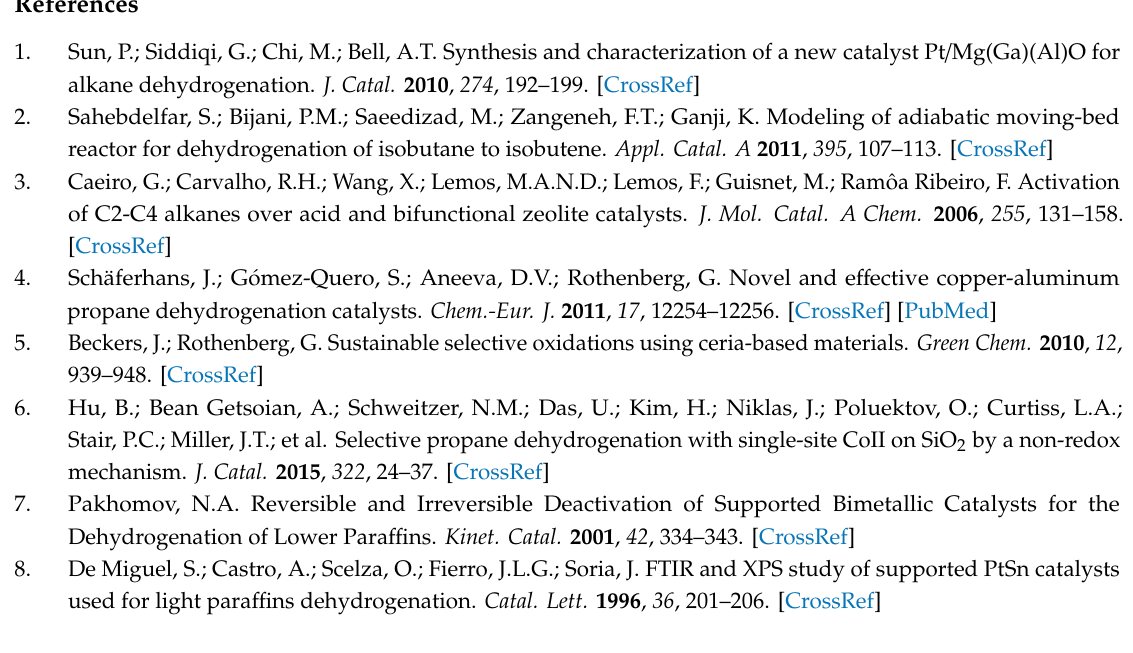
Figure S1: XRD patterns of precursors (A) and the corresponding calcined samples (B): (a) ZnO; (b) MAZ; (c) In / MAZ; (d) PtIn / MAZ. Table S1. Comparison of the catalytic performance of some state-of-the-art catalysts used in propane